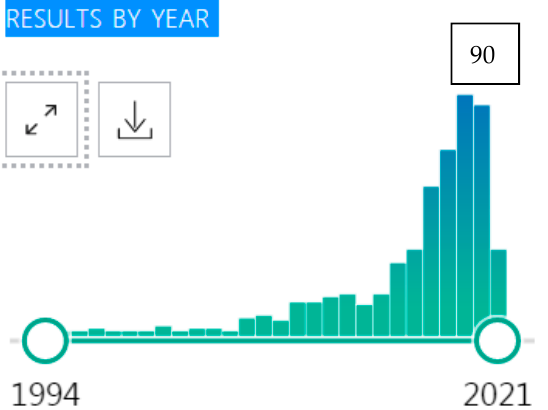
Figure 1. Number of publications on quality of life (QoL) in hidradenitis suppurativa (HS) per year in PubMed (https://pubmed.ncbi.nlm.nih.gov/?term=hidradenitis%20suppurativa%2C%20quality%20of%20life; accessed on 2 April 2021).